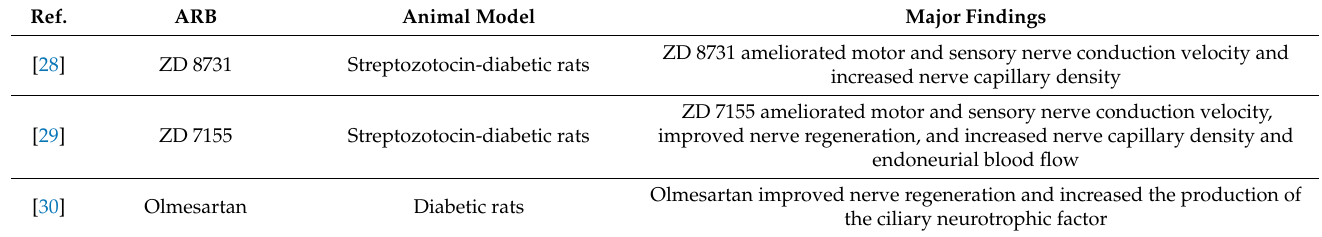
Table 1. Principal findings of preclinical studies that evaluated the effect of angiotensin receptor blockers (ARBs) on diabetic